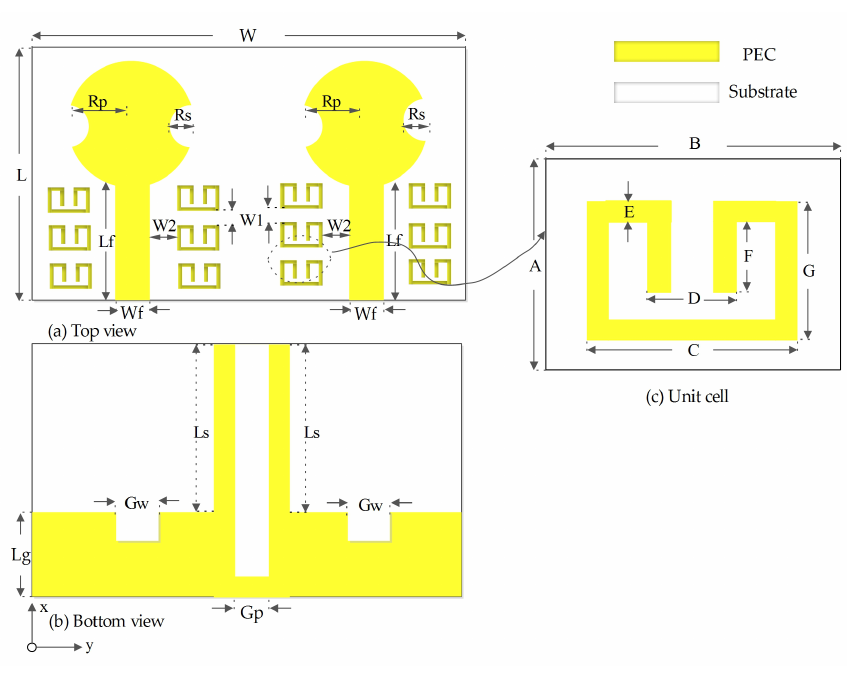
Figure 2. System model; ( a ) Top view, ( b ) bottom view, ( c ) unit cell.